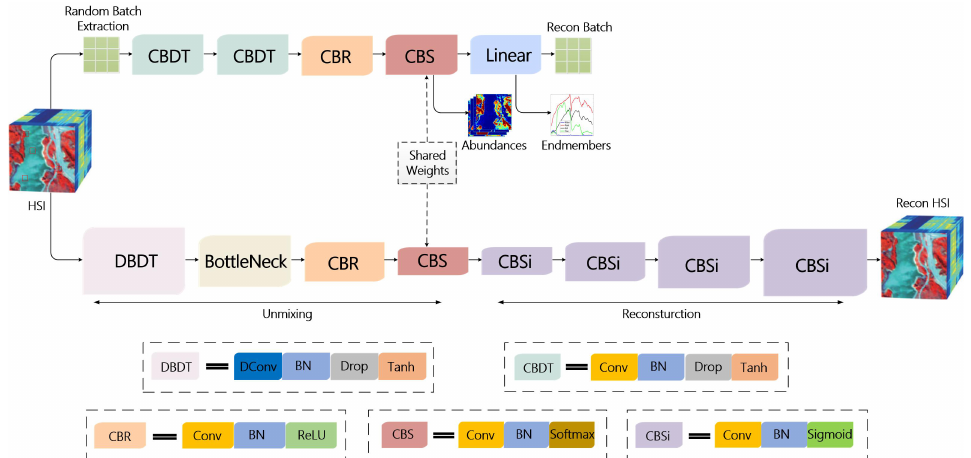
Figure 1. The architecture of SISLU-Net. The proposed SISLU-Net is a dual-branch structure. The first branch is the SCN for learning HSI spectral information. The second branch is the SPCN which learns the spatial information of the image. Spatial information learning is assisted by DBDT and bottleneck residual modules. The two branches exchange information by sharing weights and output abundance and